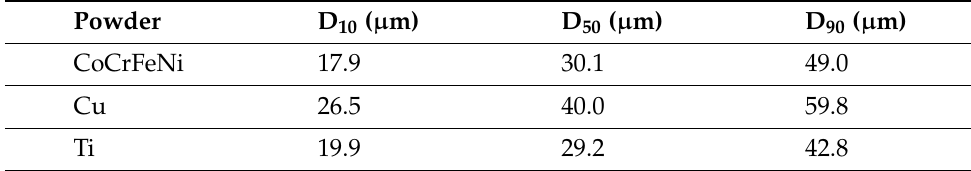
Figure 1. Secondary electron images images of the powders used for SLM. ( a ) CoCrFeNi, ( b ) Cu, ( c ) Ti. Table 2. Particle diameter percentile values prior to mixing from the laser diffraction particle size distribution for each of the powders. Where D 10 , D 50 and D 90 are the 10th, 50th and 90th percentile values of the particle diameter distribution for each